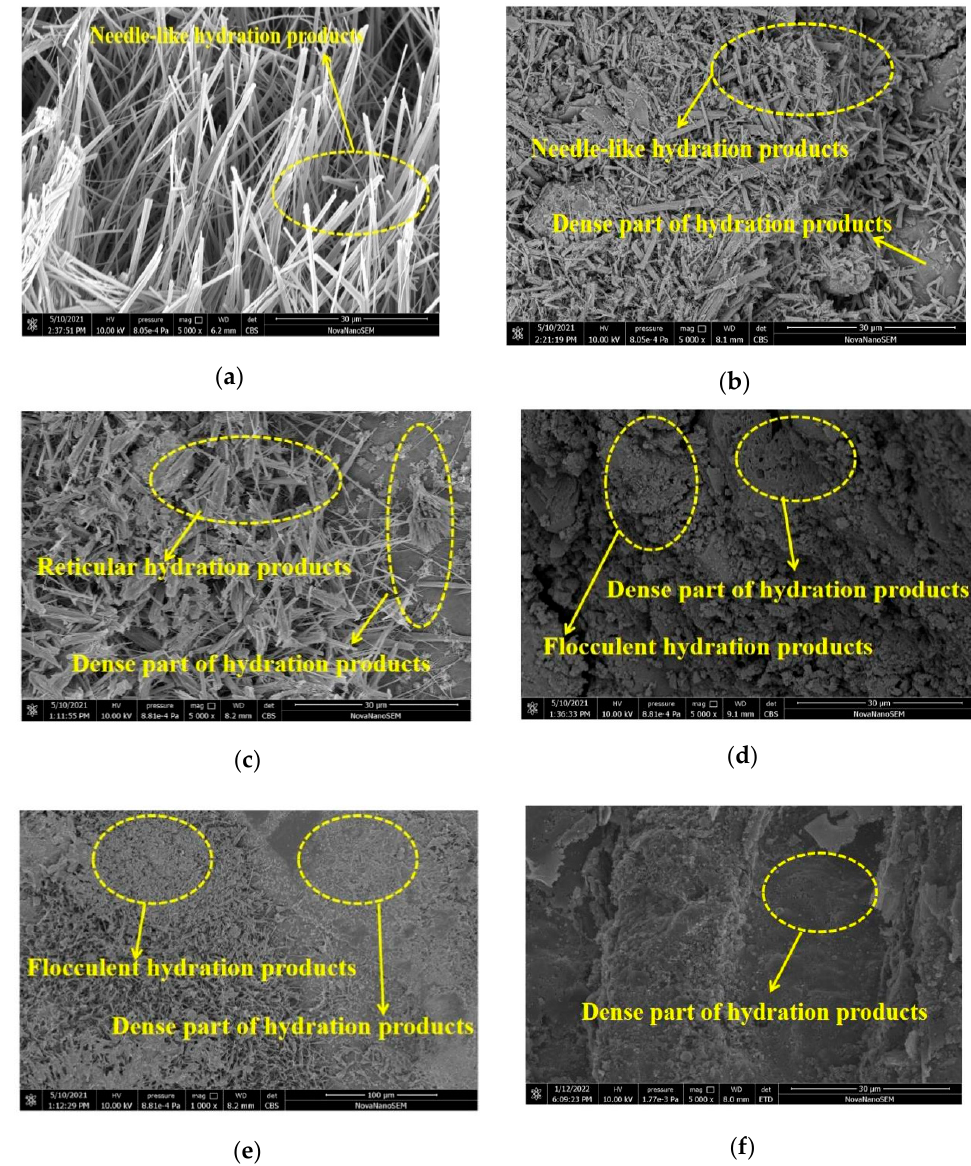
Figure 10. SEM microstructural images of RPC: ( a ) 0% WFA under standard curing for 1 day; ( b ) 10% WFA under standard curing for 1 day; ( c ) 0% WFA cured at 40 °C for 1 day; ( d ) 10% WFA cured at 40 °C for 1 day; ( e ) 0% WFA under standard curing for 28 days; ( f ) 10% WFA under standard curing for 28 days.